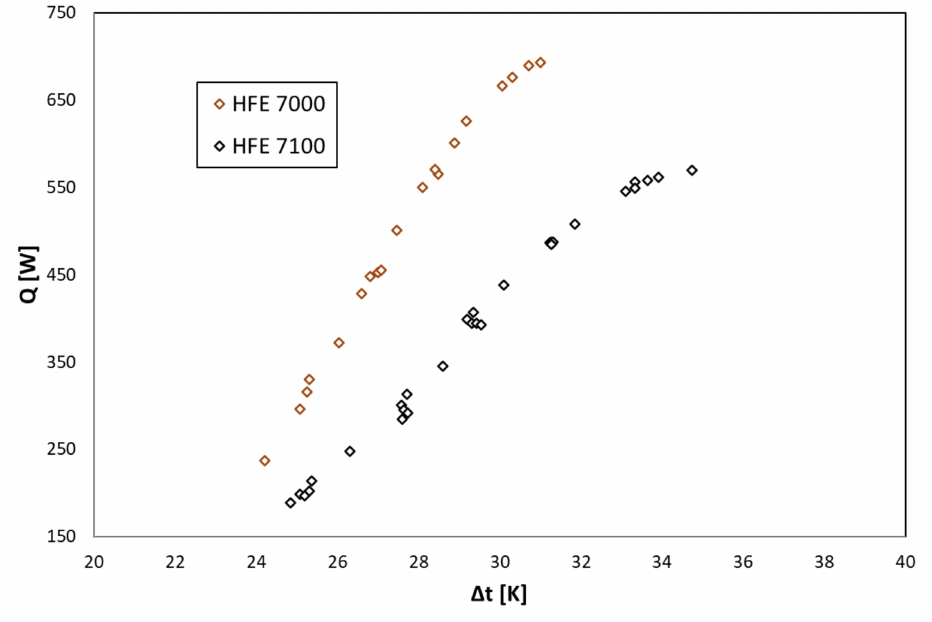
Figure 3. The dependence of the heat output of the shell-and-tube heat exchanger on the mean temperature difference of the refrigerant and the water cooling of the condenser,